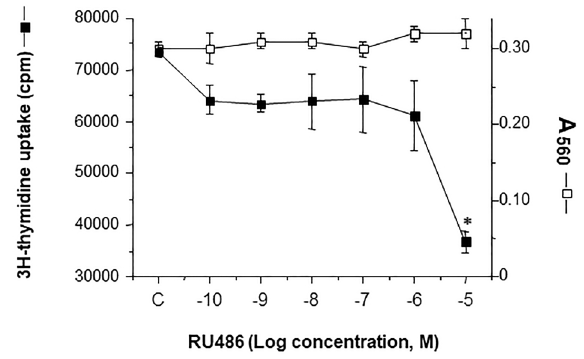
Figure 1. Effect of a 24-h treatment of SK-N-SH cells with RU486 on [3H]-thymidine incorporation and cell vitality (MTTassay). The amount of cells is reported as count per minute (cpm) or absorbance at 560 nm. Data are reported as means ± SD; *P o 0.05 vs control (C, DMSO).